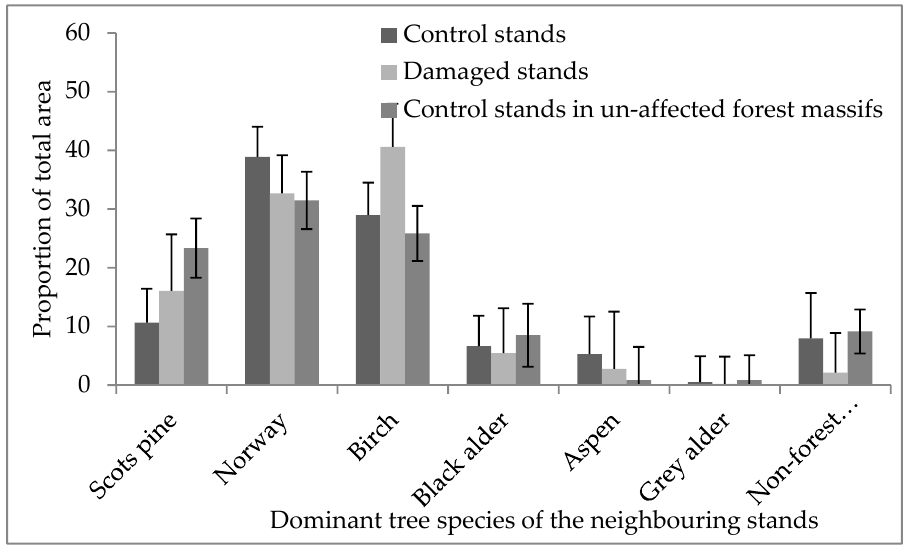
Figure 4. The distribution of dominant tree cover in the areas surrounding damaged stands, control stands in affected forest massifs and control stands in unaffected forest massifs (±95% confidence interval).